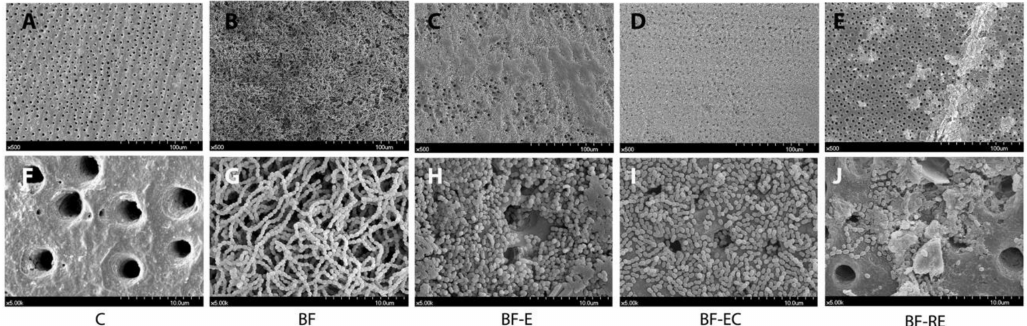
Figure 2. SEM images of S. mutans biofilms grown on dentin discs after surface treatment. ( A , F ) Control, ( B , G ) biofilm formation and no surface treatment, ( C , H ) biofilm formation and treatment with acid etching, ( D , I ) biofilm formation and treatment with acid etching and chlorhexidine, and ( E , J ) biofilm formation and treatment with prophylaxis with pumice and acid etching ( A – E : 500 × magnification, F – J : 5000 × magnification).